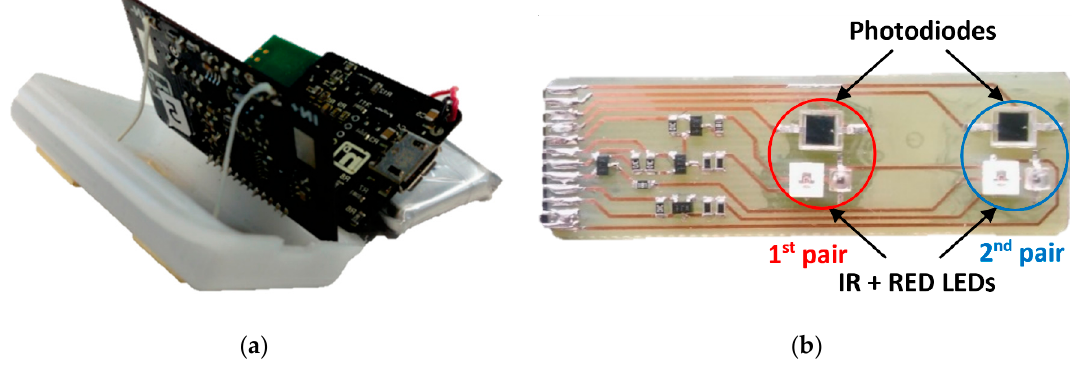
Figure 10. ( a ) Pulse-oximetry Holter, ( b ) paired pulse-oximetry sensors.